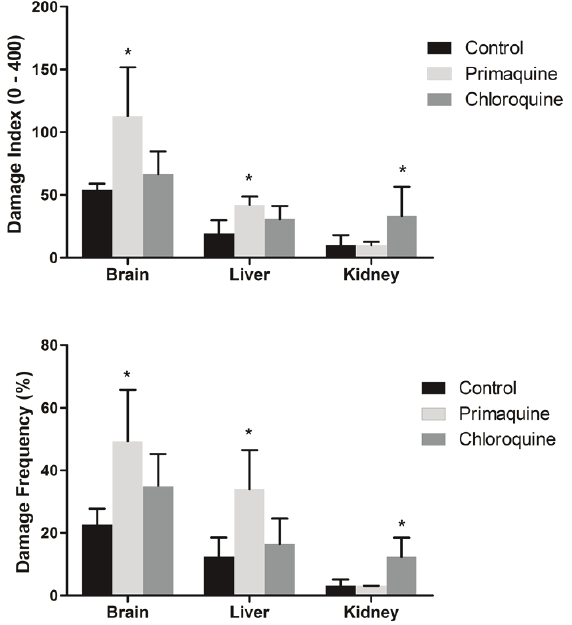
Figure 1 - Effect of 7days of administration of primaquine and chloroquine on frequency and index of DNA damage in brain, liver and kidney of rats (n = 7 per group). Data were analyzed by one-way analysis of variances followed by the Tukey test when F was significant. Values are expressed as mean ±